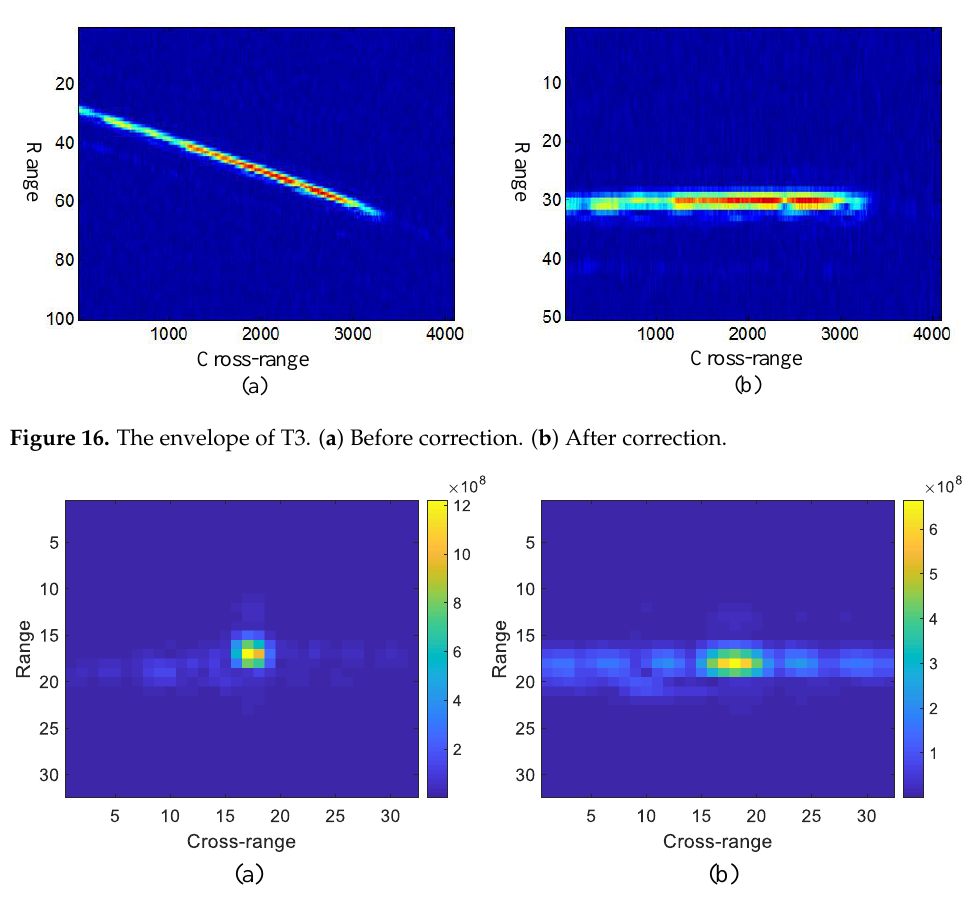
Figure 17. The imaging result of T3. ( a ) HPC-GMTIm (entropy = 2.48). ( b ) GHHAF method (entropy =